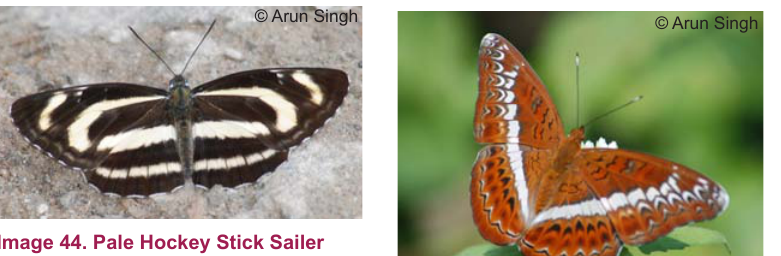
Image 44. Pale Hockey Stick Sailer Neptis